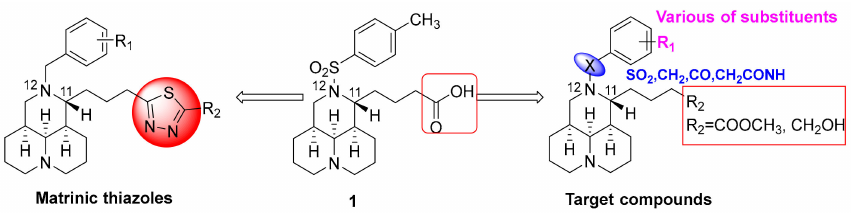
Figure 1. Chemical structures of lead 1 and structural modification